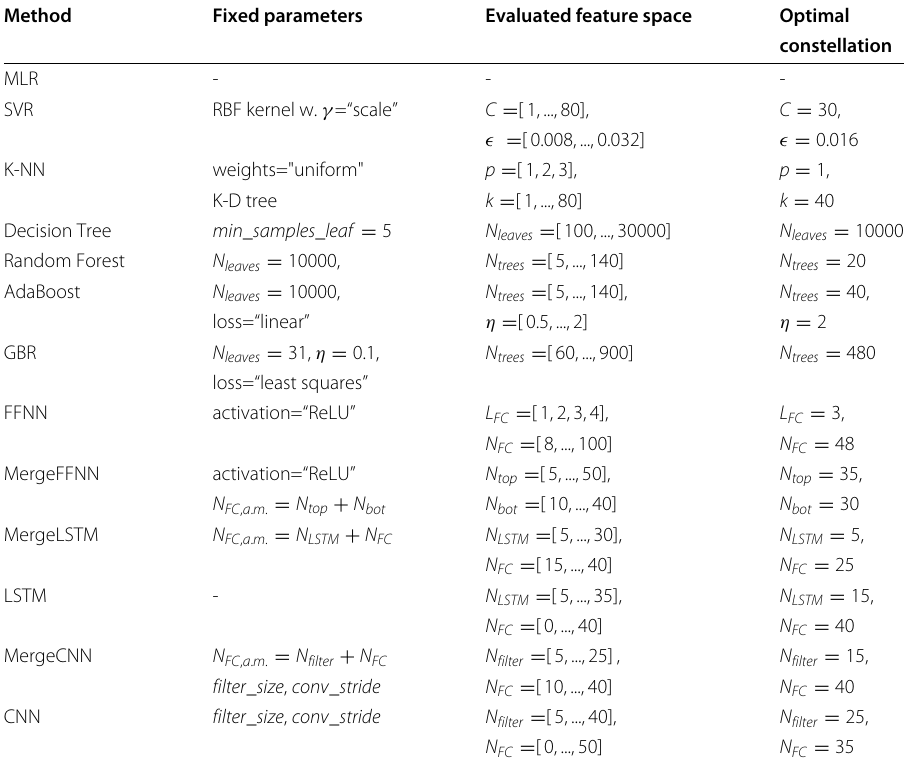
Table 1 Table showing the fixed parameters during evaluation, and the parameters, which are optimized by using grid search Method Fixed parameters Evaluated feature space Optimal